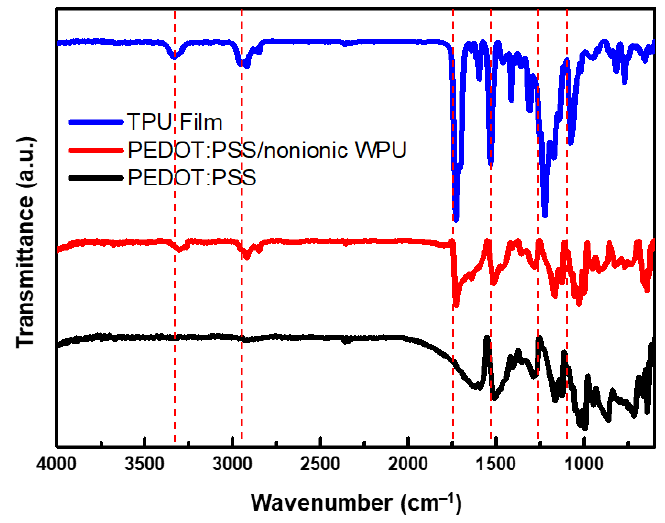
Figure 4. FTIR spectra of TPU film (Bare), PEDOT:PSS/nonionic WPU, and PEDOT:PSS coated on TPU film.